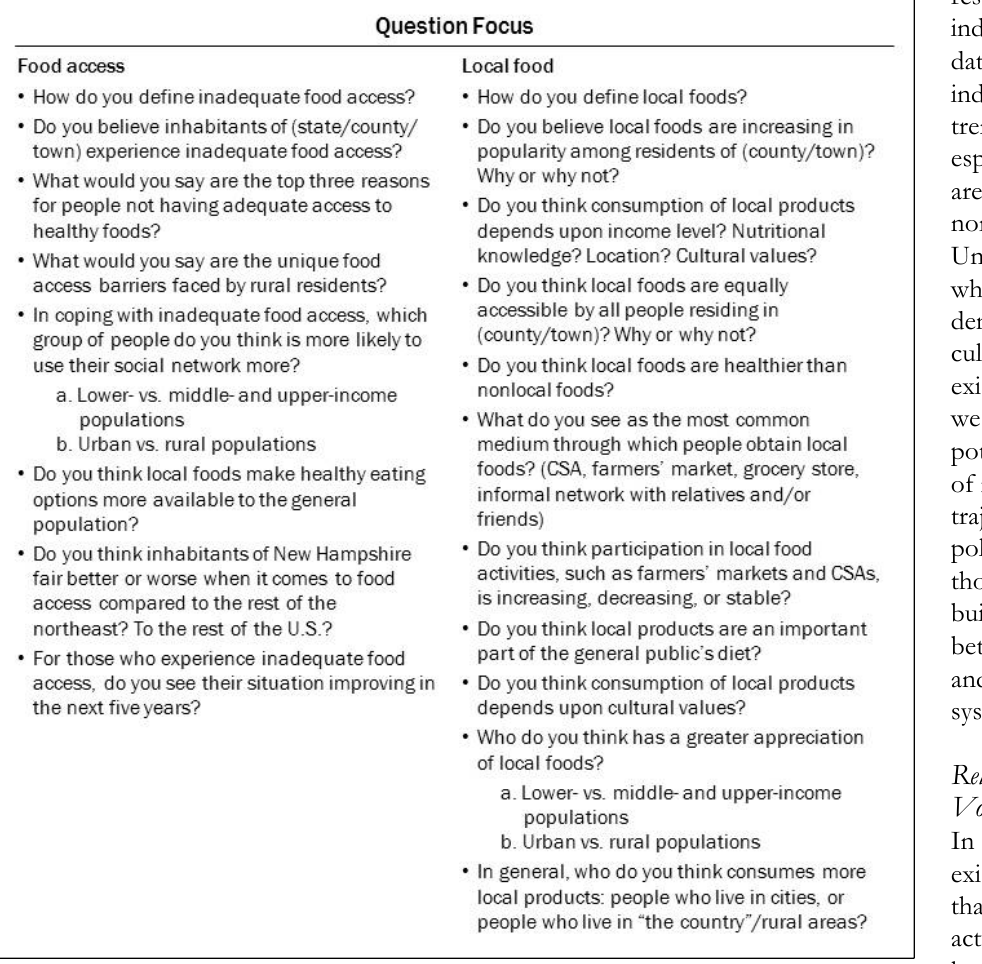
Table 1. Sample Question Template Used To Interview